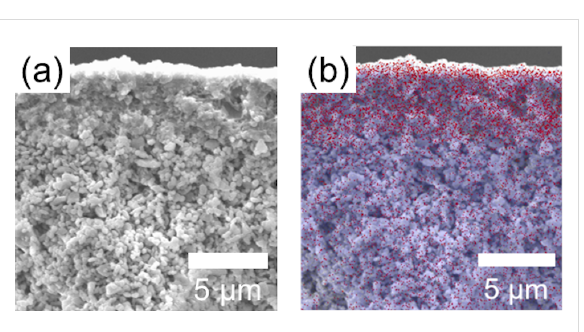
Figure 6: (a) Cross-sectional view FE-SEM image of the synthesized ZIF-8 membrane. (b) Cross-sectional view EDS mapping of the synthe- sized ZIF-8 membrane (red represents Zn; blue represents